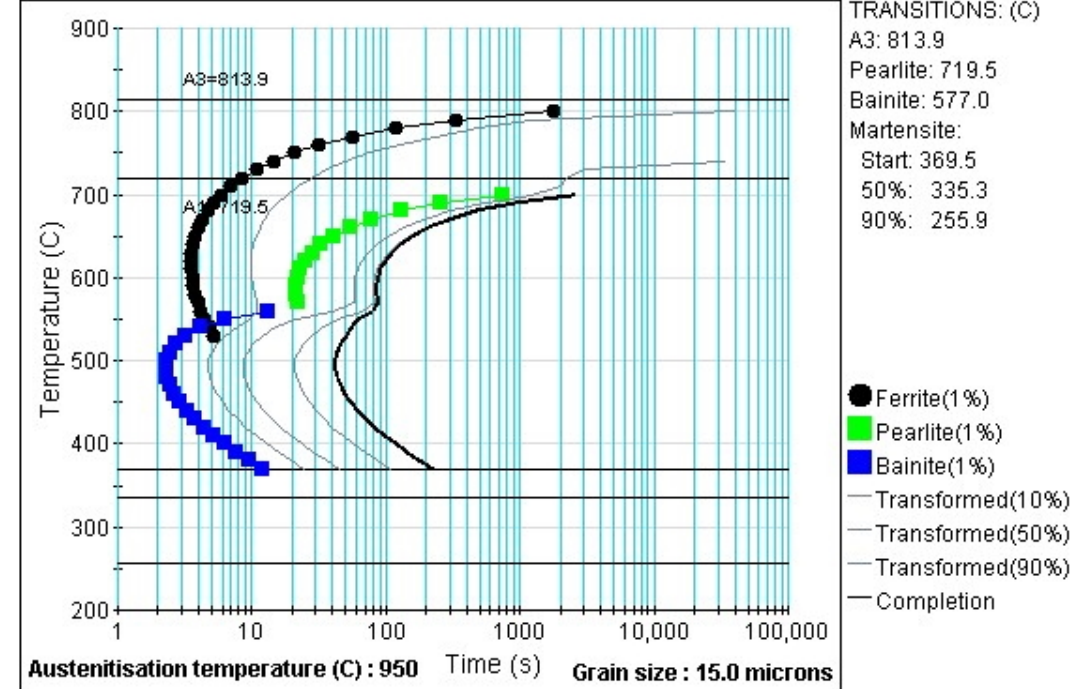
Figure 14. TTT diagram for 22MnB5 steel calculated in JMatPro software (version 12.1).